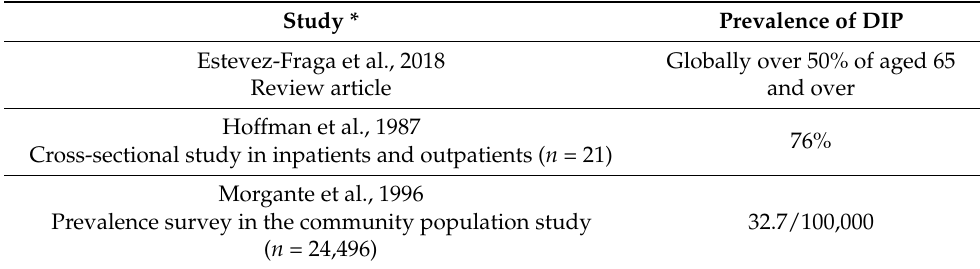
Table 1. Prevalence and Incidence of DIP.